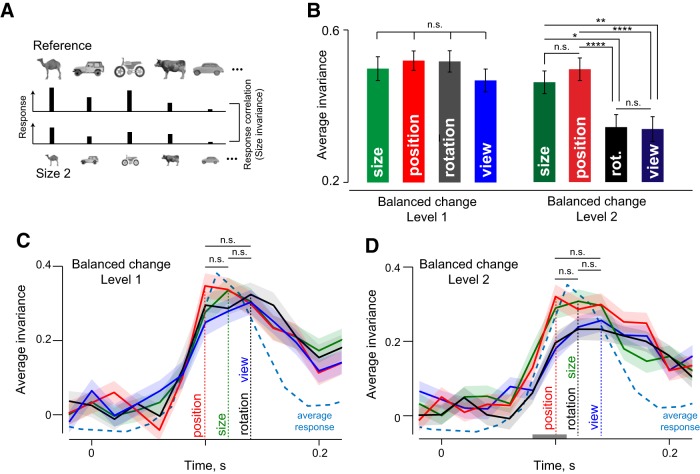
Dynamics of invariance in IT neurons. A, To quantify size invariance, we calculated the correlation between the responses to the reference images of all objects (top row) and the responses to size-transformed images of these objects (bottom row). B, Average size, position, rotation, and view invariance across all neurons for balanced change level 1 (left) and level 2 (right). Error bars indicate SEM. Asterisks indicate statistical significance (* is p < 0.05, ** is p < 0.005, *** is p < 0.0005, **** is p < 0.00005). C, Average size, position, rotation, and view invariances (for change level 1) in 20-ms bins during the image presentation period (200 ms). Vertical dashed lines indicate the peak latency for each invariance type. The average normalized neural response (across all cells and stimuli) is displayed (cyan dashed line) for comparison. D, Same as C but for larger changes (level 2). The gray bar near the x-axis represents the time period during which the average of size and position invariance was significantly larger than the average of rotation and view invariance (p < 0.05, rank-sum test across invariances of 127 neurons in each time bin).